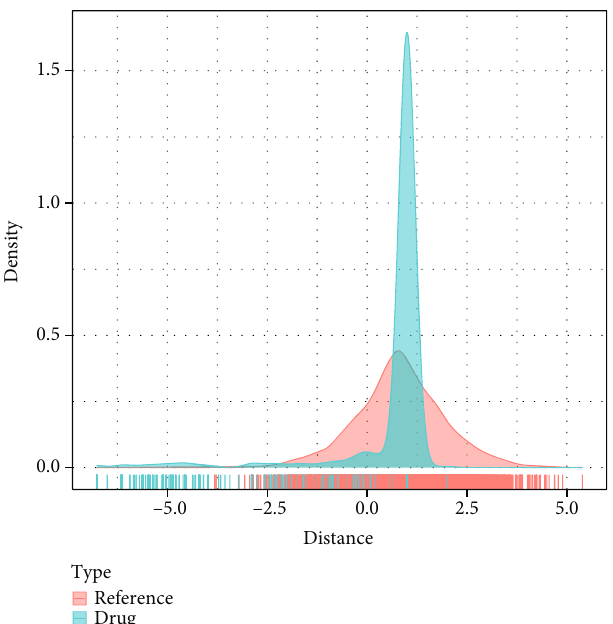
Figure 6: Distance density scaling diagram of drug to F9-related gene